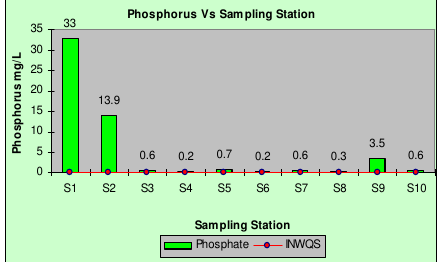
Figure 8. Biological Oxygen Demand vs. Sampling Station Nutrient Parameters.